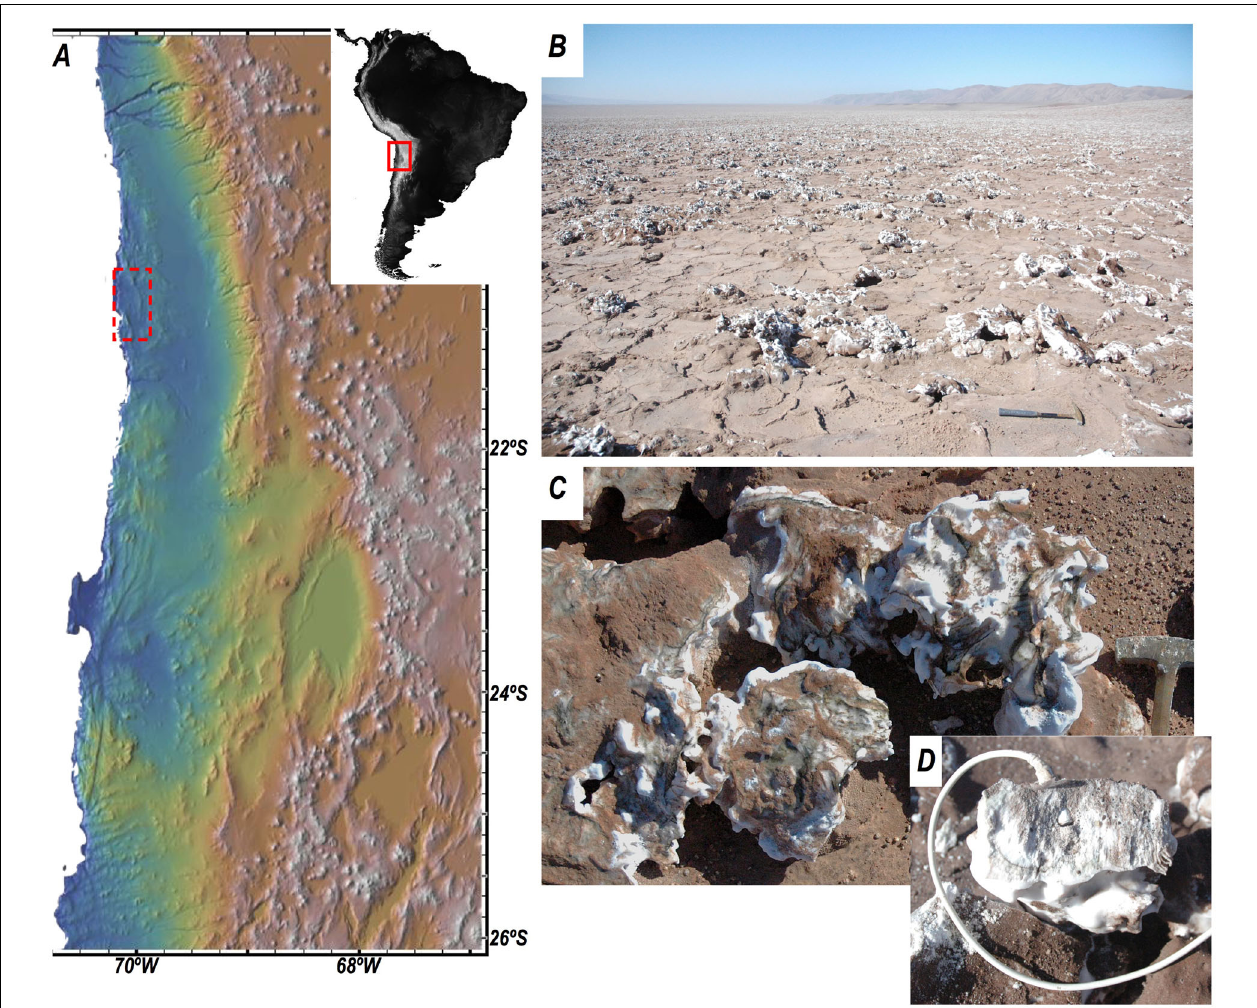
FIGURE 1 | (A) Elevation map showing the location of Salar Grande (red dotted rectangle) in the Atacama Desert of northern Chile. (B) Panoramic view of Salar Grande (looking south) with salt polygons and nodules in the foreground. (C) Close-up view of a colonized salt nodule. The surface of the nodule shows the typical dark-green colorization due to exposed endolithic communities. (D) T/RH sensors inside a salt nodule (image taken at the end of the field